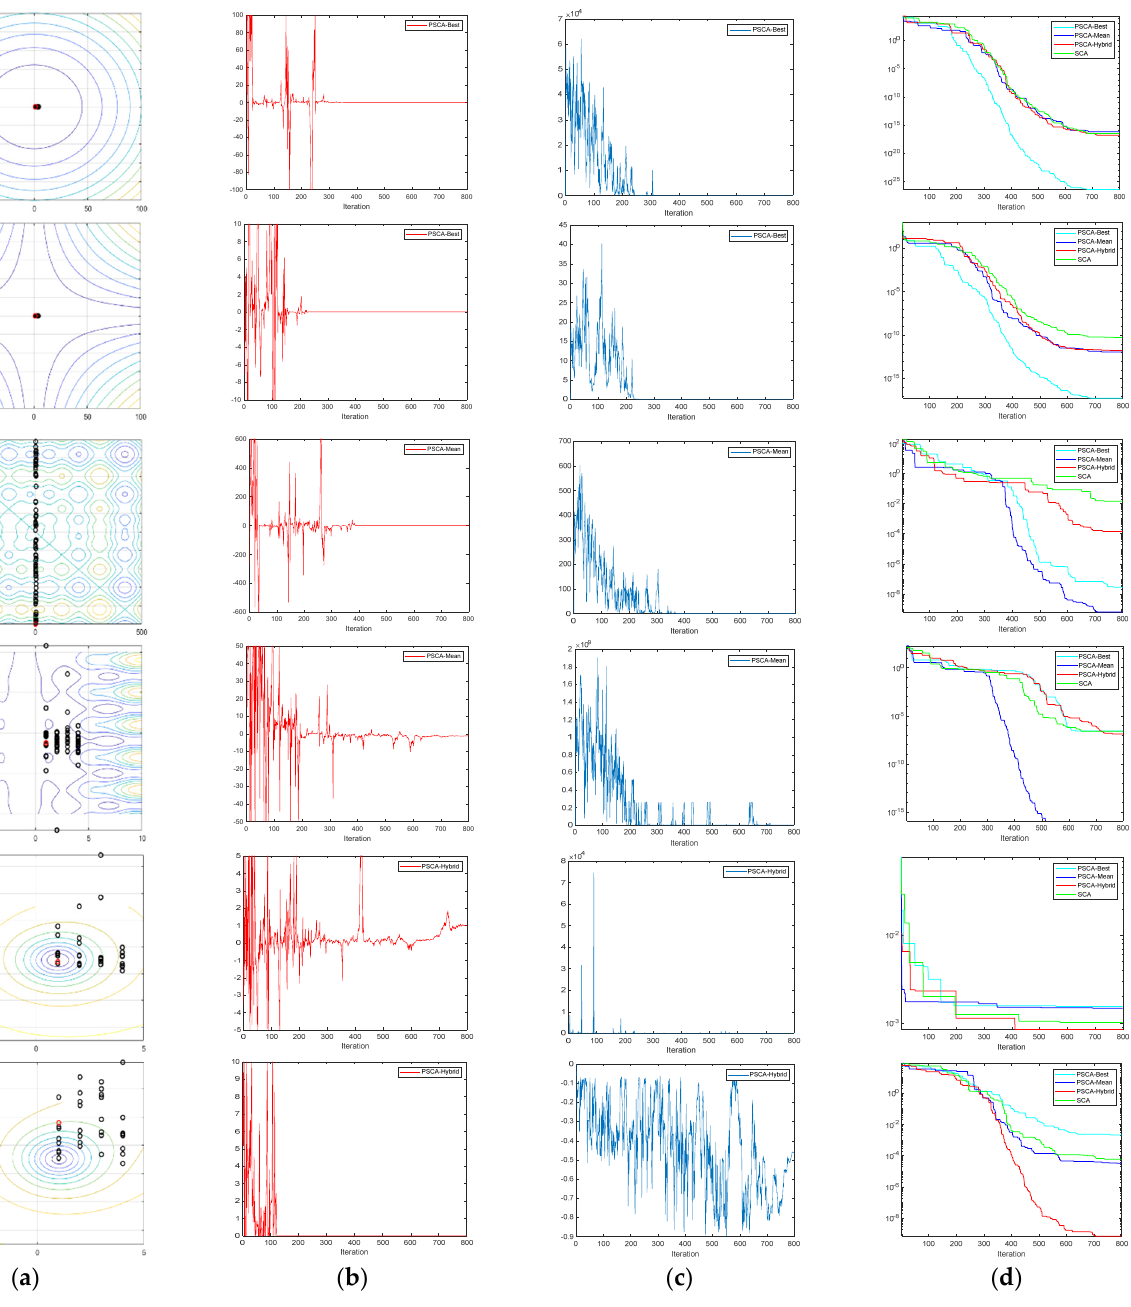
Figure 4. Optimization results of the benchmark: ( a ) 2D position distribution; ( b ) Trajectory in the first dimension; ( c ) Average fitness; ( d ) Convergence curves. Table 5. Parameter level